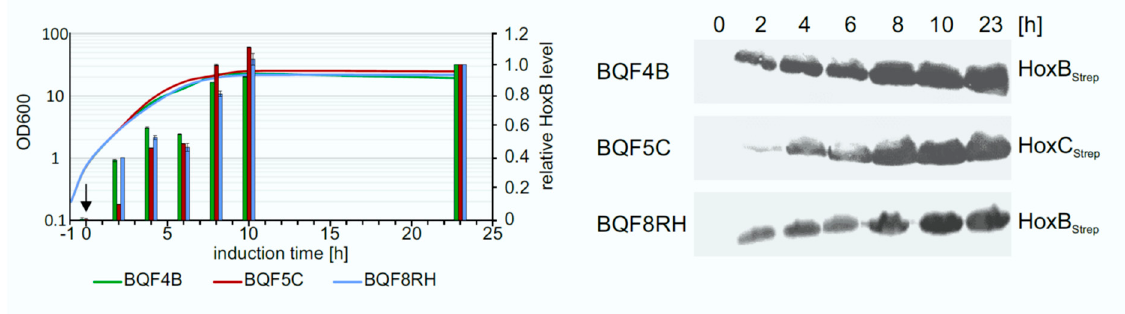
Figure 4. Time-dependent overproduction of HoxB Strep , HoxC Strep and RH. Strains BQF4B, BQF5C, and BQF8RH were cultivated in 50 mL TB medium at 30 ◦ C in UYF. Samples normalized to OD 600 of 5 were taken at the indicated time points after the addition of 50 µM IPTG (t = 0 h). Production of Hox proteins was analyzed by Western blotting. Growth curves of the different strains and relative Hox protein levels ( left ) as quantified from the Western blot ( right ). The individual protein levels after 23 h of induction were set to 1.